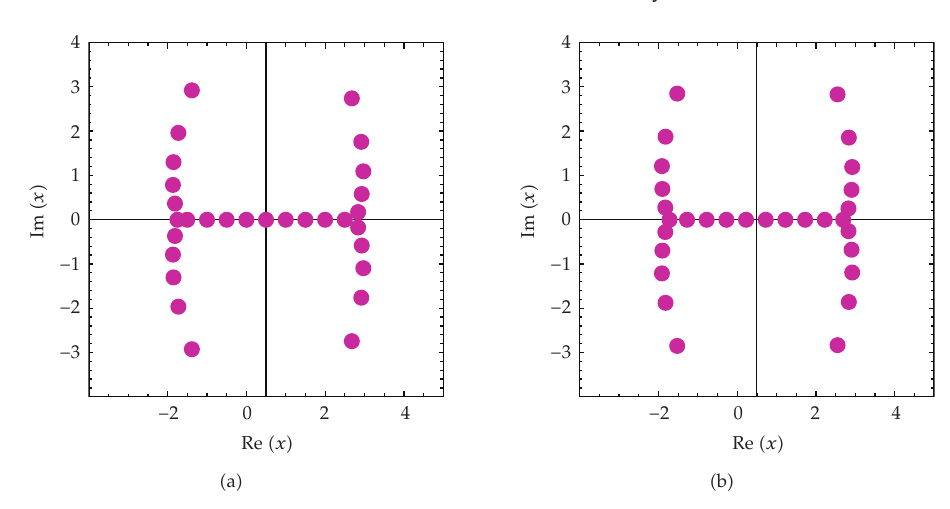
(cid:2) 3 (cid:3) (cid:2) x (cid:3) for q (cid:6) 9 / 10 , 99 / 100. n, 30